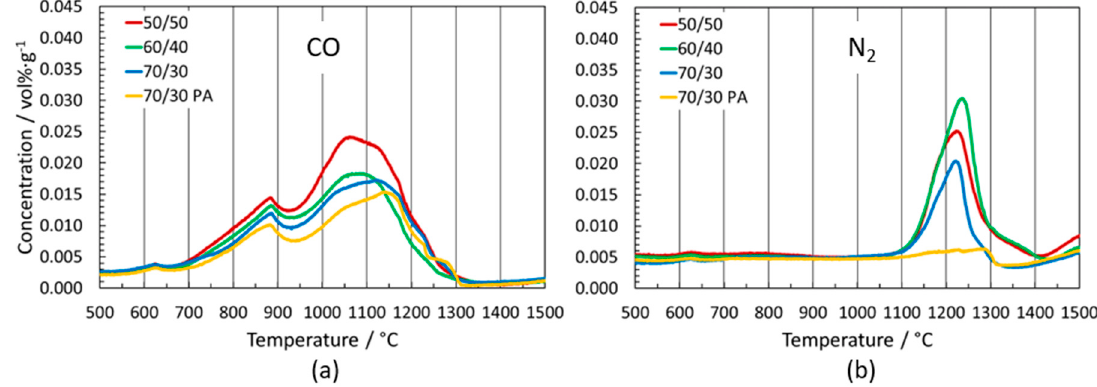
Figure 2. CO ( a ) and N 2 ( b ) outgassing of cermet formulations Ti(C,N)-WC-(Ta,Nb)C-Co/Ni with different C/N ratio of the admixed Ti(C,N), nominally Ti(C 0.5 N 0.5 )—“50/50”, Ti(C 0.6 N 0.4 )-A—“60/40” and Ti(C 0.7 N 0.3 ) “70/30” and one grade with admixed “pre-alloyed” (Ti,W)C, corresponding in overall composition to that of the Ti(C 0.7 N 0.3 )-containing formulation (“70/30 PA”).